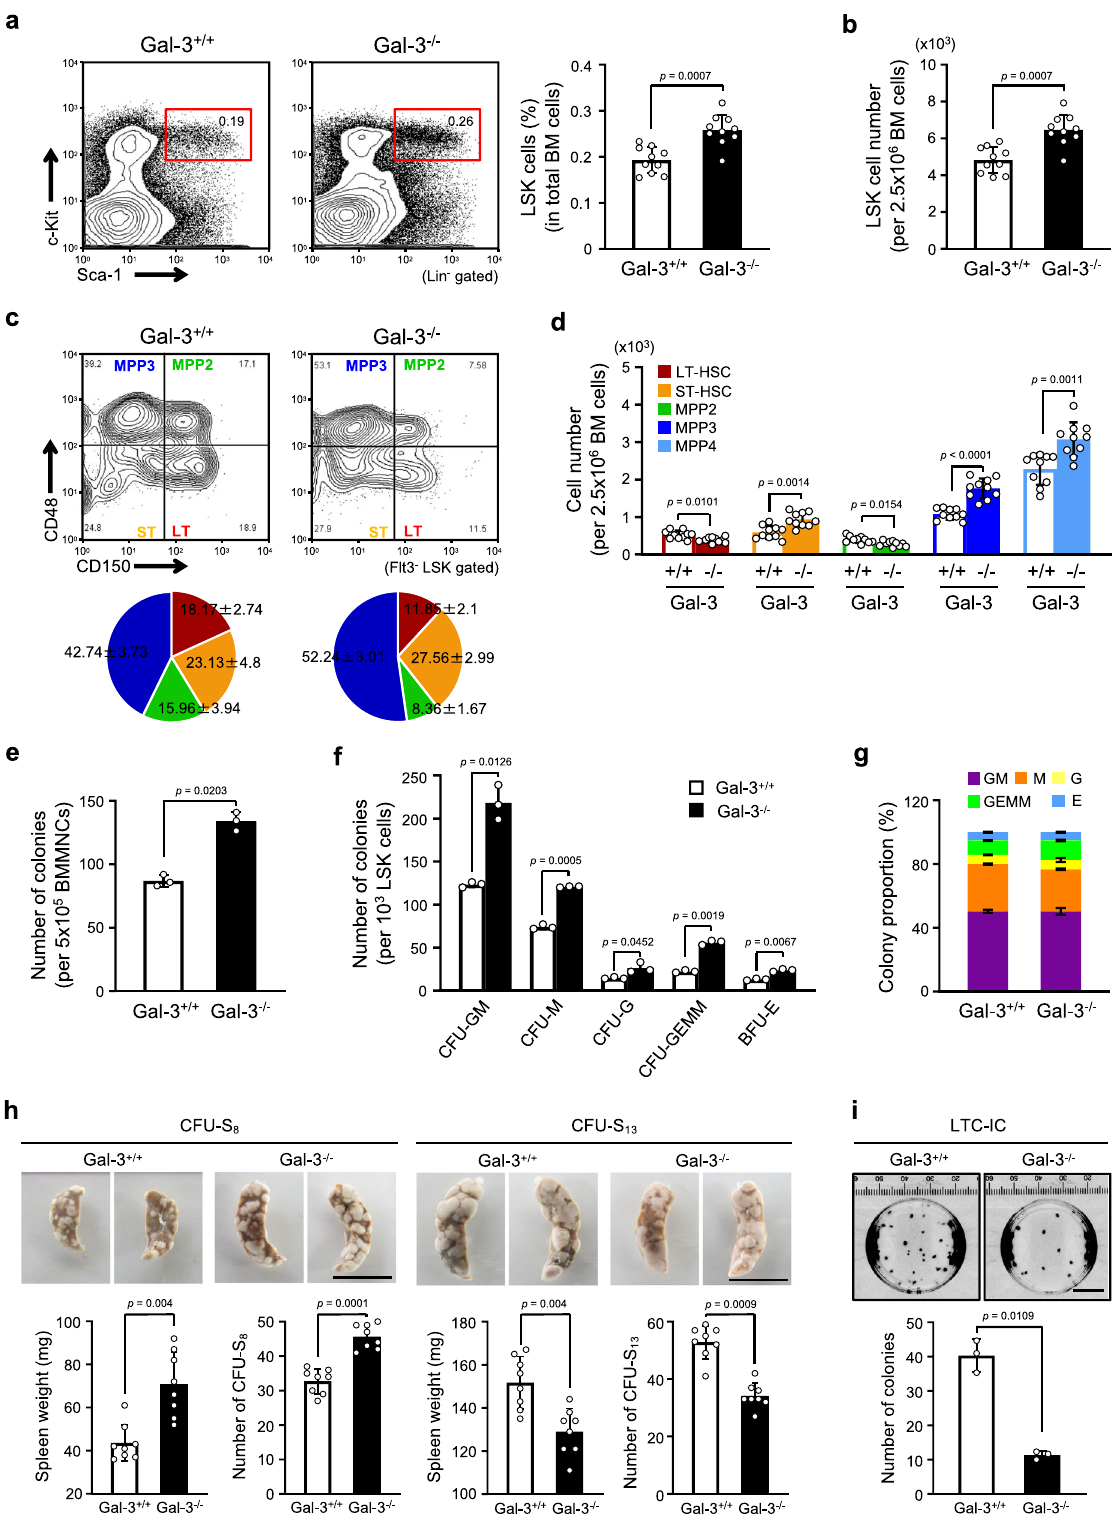
and S/G 2 /M were seen in BM from Gal-3 − / − mice (Fig. 3a).